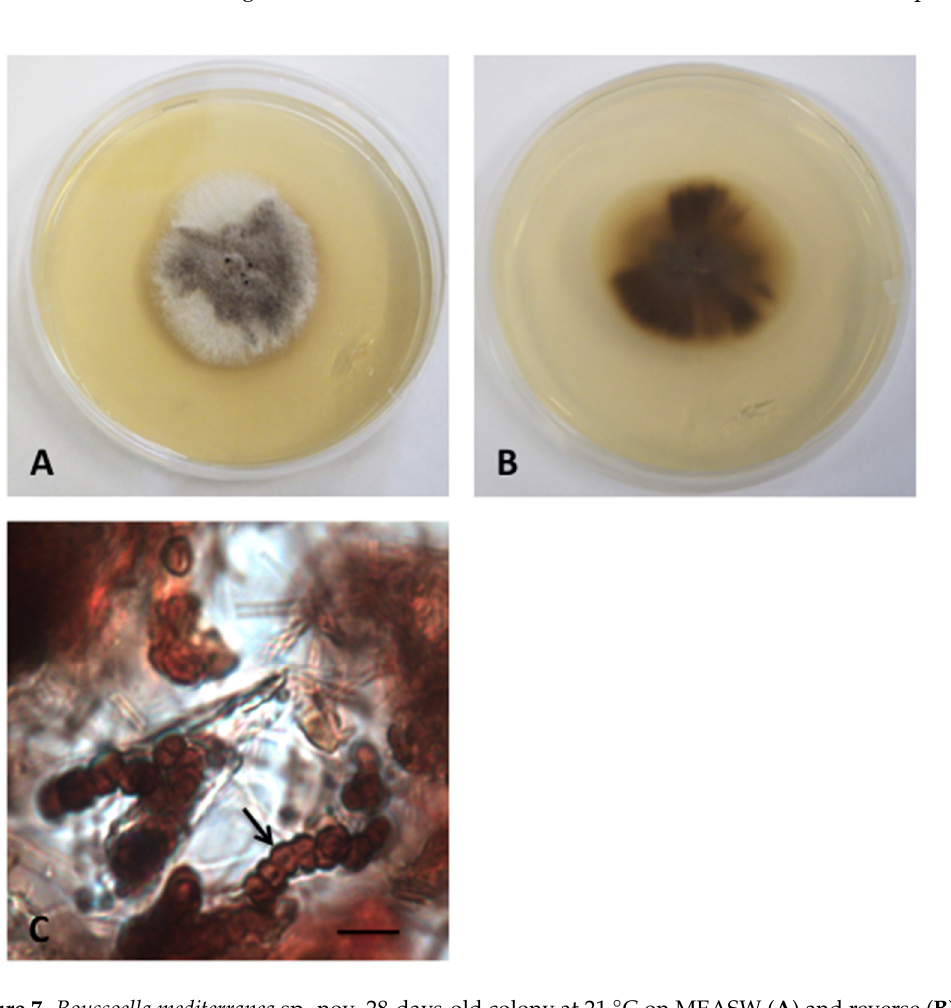
Figure 7. Roussoella mediterranea sp. nov. 28-days-old colony at 21 °C on MEASW ( A ) and reverse ( B ); unicellular and multicellular chlamydosporesn indicated by a black arrow ( C ). Scale bar: 10 µm. Roussoella padinae sp. nov. V. Prigione, E. Bovio, A. Poli and G.C. Varese